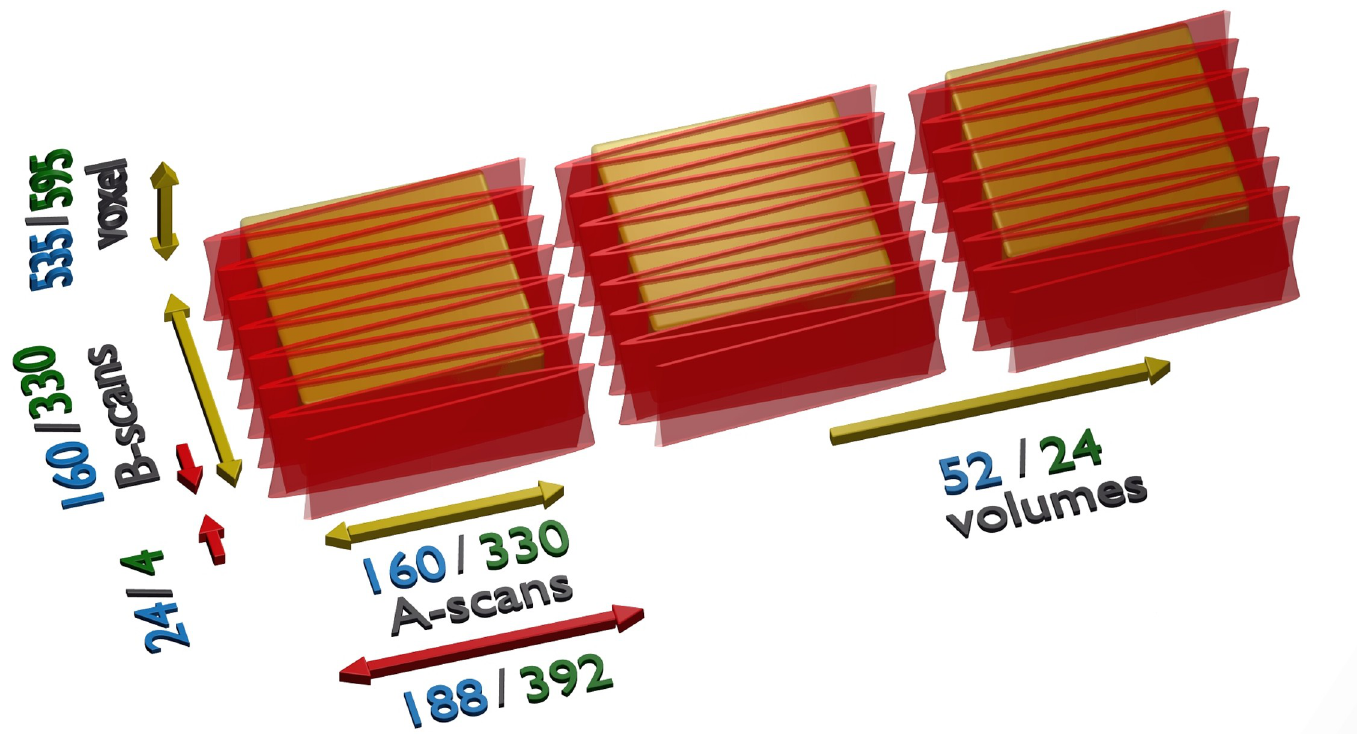
Fig 3. Scan pattern. Red arrows and beam-path denote length of a complete scan. Yellow arrows and box show actual acquired volume. Blue numbers show the non-live imaging case, green numbers the live imaging case.